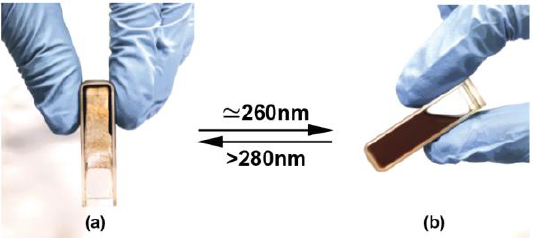
Figure 8. Photoreversible reaction: ( a ) crosslinked network; ( b ) de-crosslinked network.